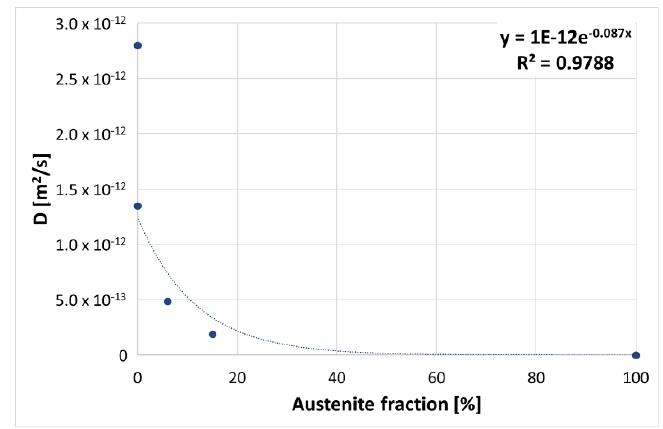
Figure 11. Exponential regression of the hydrogen diffusion coefficient as a function of the austenitic phase fraction.